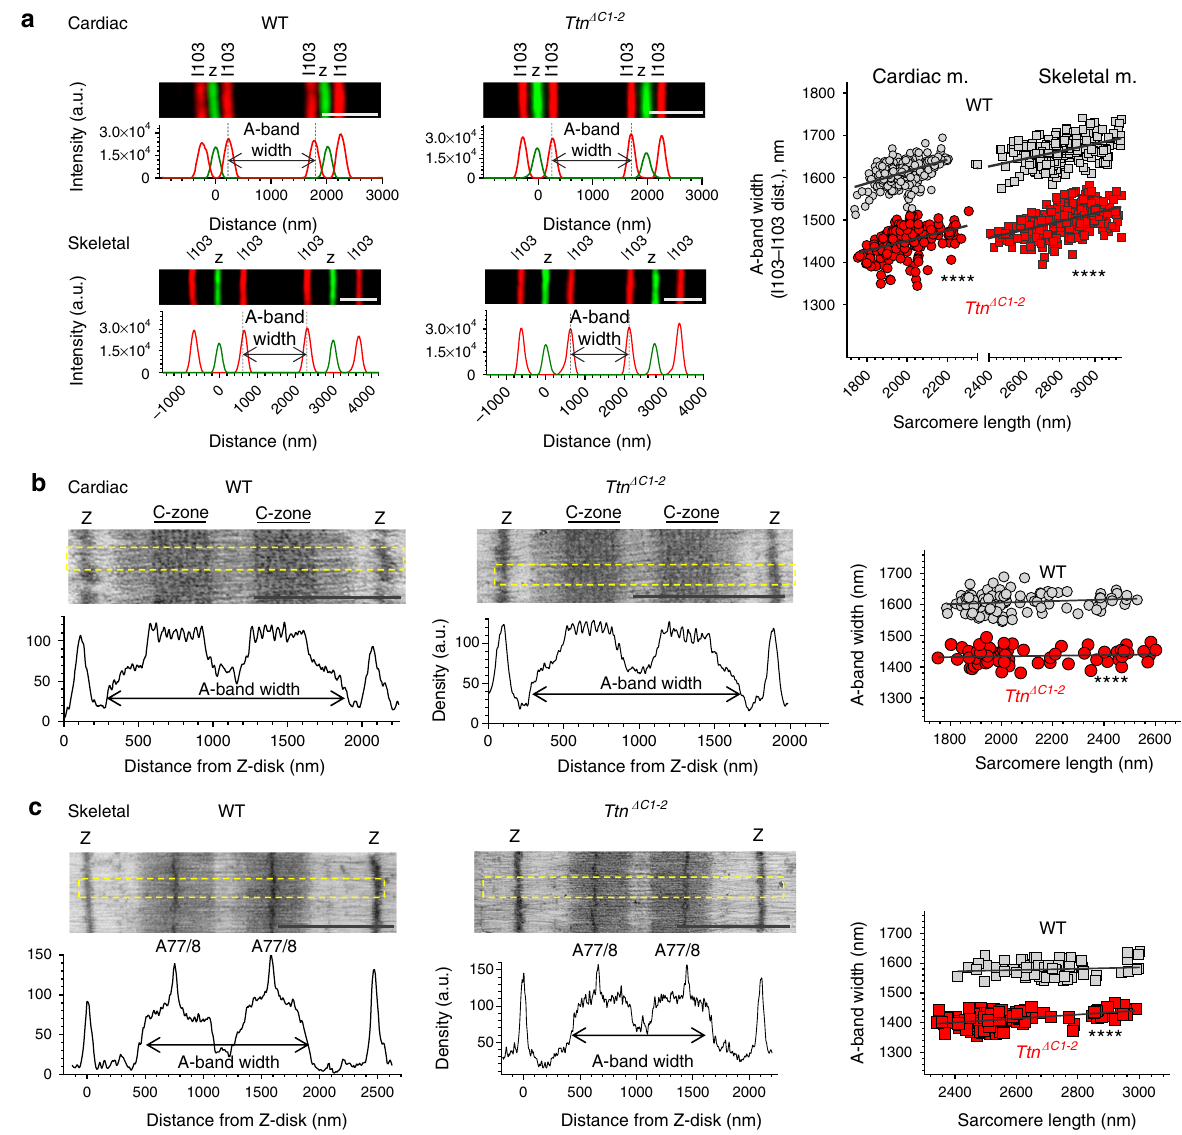
Fig. 2 Effects of deleting C-zone repeats on A-band width. a Left, example of SIM images obtained using cardiac and skeletal muscle sections labeled with I103 titin antibody (A-band, red) and α -actinin (Z-disk, green). Right, summarized results of the A-band width measurements. In both muscle types the offsets of the linear regression lines are signi fi cantly lower in Ttn Δ C1-2 mice. b , c Left, representative IEM images of sarcomeres labeled with cMyBP-C ( b ) or A77/8 ( c ) with density pro fi les shown at bottom. Obtained summarized results are shown to the right. c The distance between A77/8 epitopes was measured and used to determine A-band shrinkage in skeletal muscle. Right, Shrinkage-corrected A-band width results. All linear regression fi ts show positive slopes but none are signi fi cantly different from zero. Line offsets are signi fi cantly reduced in Ttn Δ C1-2 mice. Statistical analysis is provided in Supplementary Table 4 (**** denotes p < 0.0001). Scale bars, 1 μ m. The 8-week-old male mice were used (SIM: 10 WT and 9 Ttn Δ C1-2 , IEM: 4 WT and 4 Ttn Δ C1-2